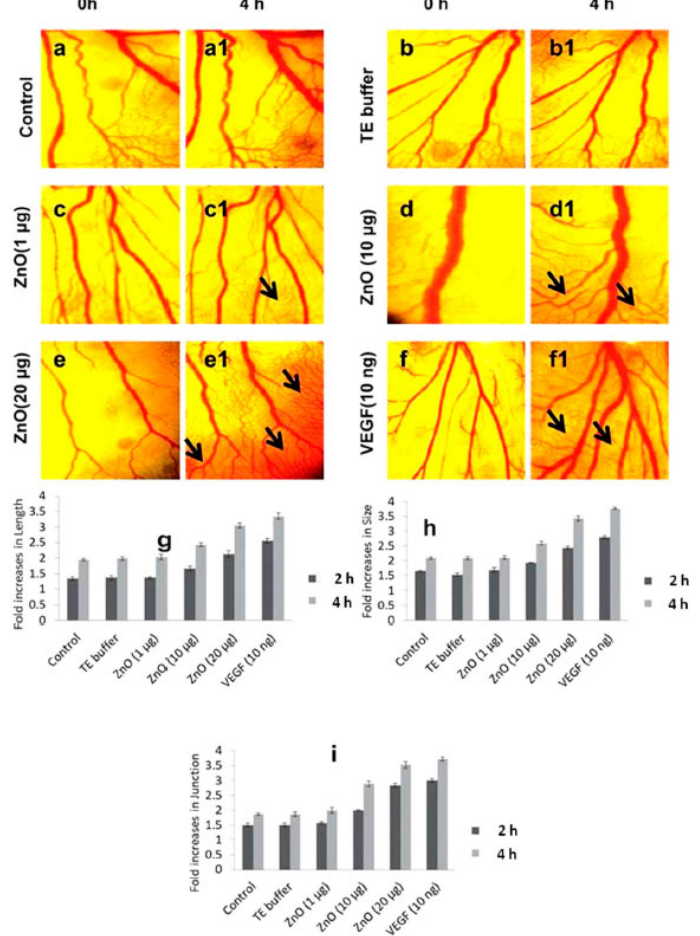
Figure 14. Chick embryo angiogenesis (CEA) assay with ZnO nanoflowers for in vivo angiogenesis assay. ( a , a1 ) Untreated chicken egg yolks were considered as control; ( b , b1 ) TE (Tris–Ethylenediamine Tetraacetic Acid) buffer; ZnO nanoflowers at different concentrations (1–20 mg) ( c , c1 , d , d1 , e , e1 ); and vascular endothelial growth factor (VEGF) (10 ng) as positive control experiment ( f , f1 ), respectively. A dose-dependent increase of matured blood vessel formation was observed with the increasing concentration of ZnO nanoflowers. The black arrows indicate the formation of new vasculature. Three angiogenesis parameters were quantified: vessel length ( g ); vessel size ( h ) and junction ( i ). Reproduced with permission from reference [20]. Copyright (2012) Royal Society of